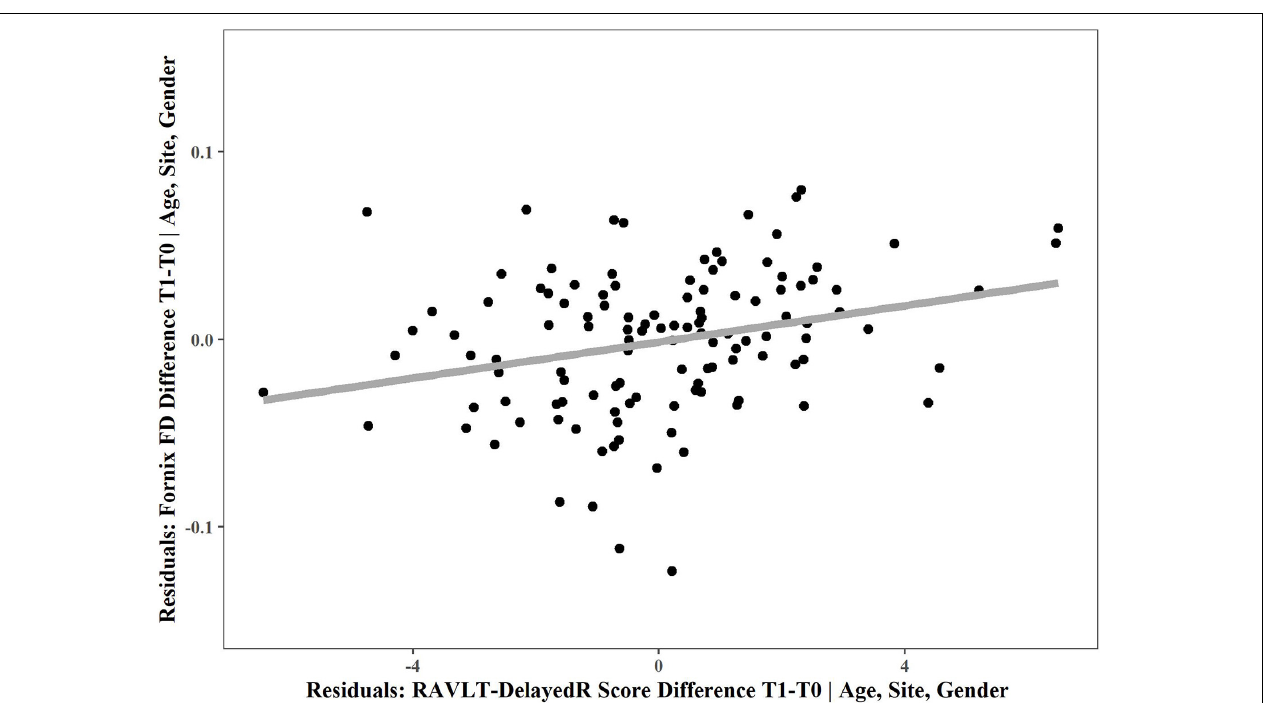
FIGURE 3 | Non-parametric partial correlation between fornix FD and RAVLT-DelayedR changes. Non-parametric partial correlation, controlling for age (at the start of the intervention), site and gender revealed a significant correlation between fornix FD change and change in RAVLT-DelayedR performance (measuring episodic (long-term) verbal memory). For visualization, the residuals of multiple regression are plotted and a linear regression line was chosen to depict the positive correlation. T0, baseline measurement; T1, 6 months